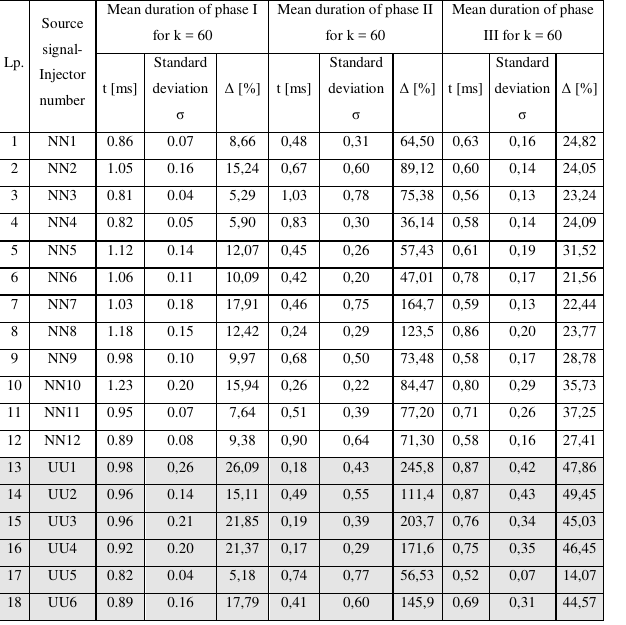
Fig. 5. A summary of the phase-change coefficients of phase III measure- ments